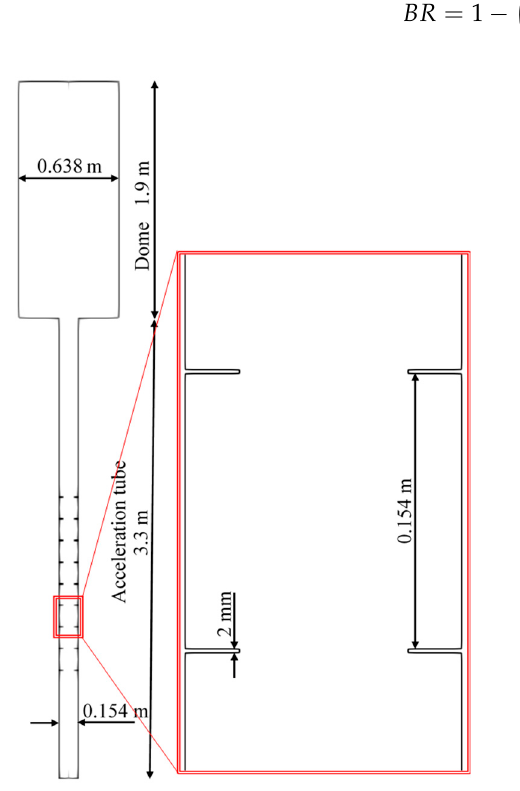
Figure 1. The scheme of the ENACCEF facility.